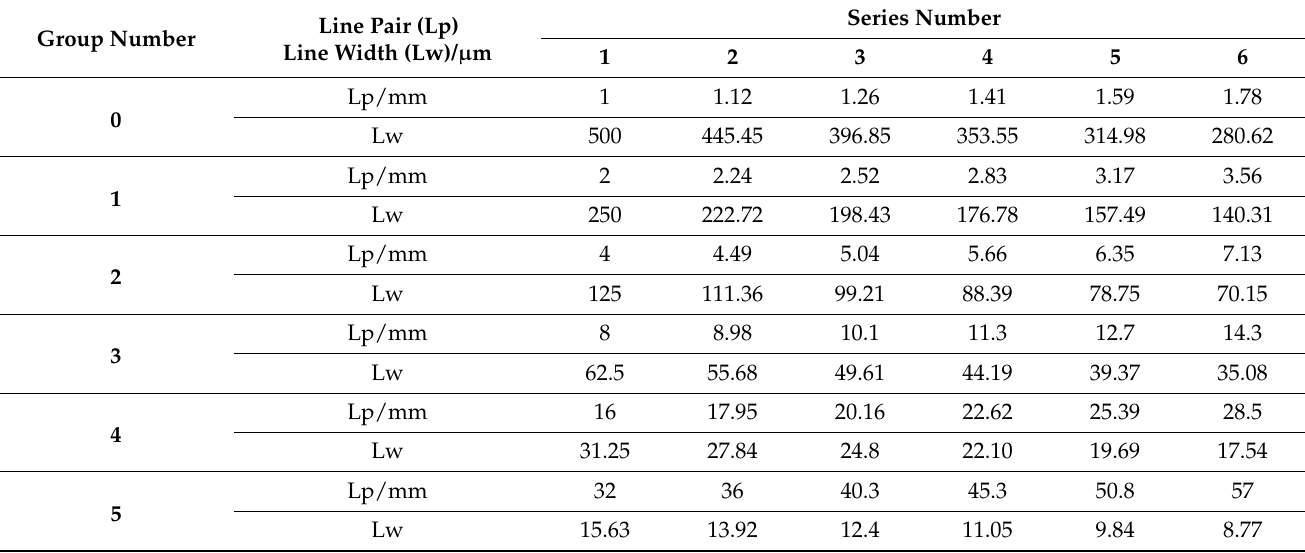
Table A1. Identification plate/resolution test panel (USAF